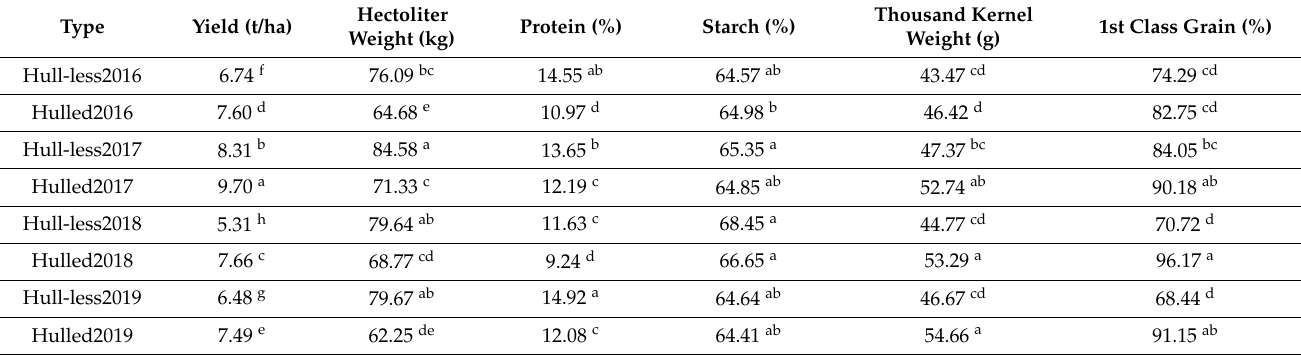
Table 3. Mean values for barley quality indicators for each year.